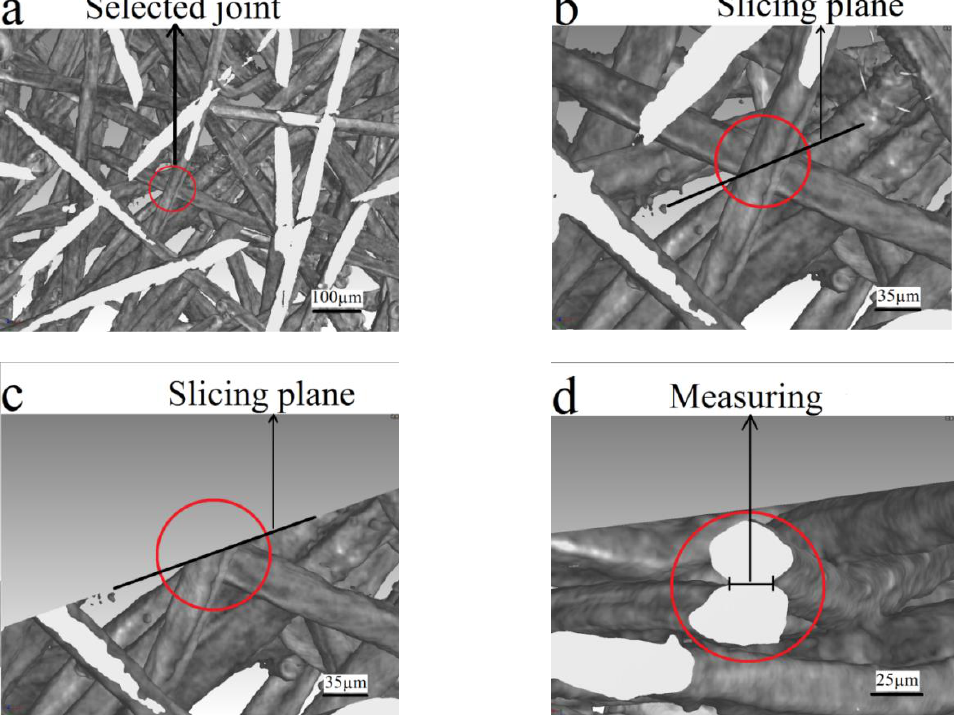
Figure 2. Measurement of neck radius of sintering joints from the computed tomography (CT) image of sintered 316L SSFFs.